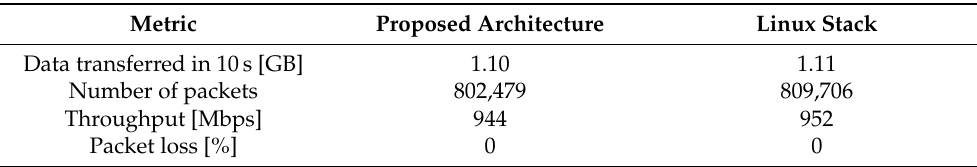
Table 1. Performance of the proposed communication architecture with OVS and the abstraction layer, versus Linux stack over ethernet measured with iperf